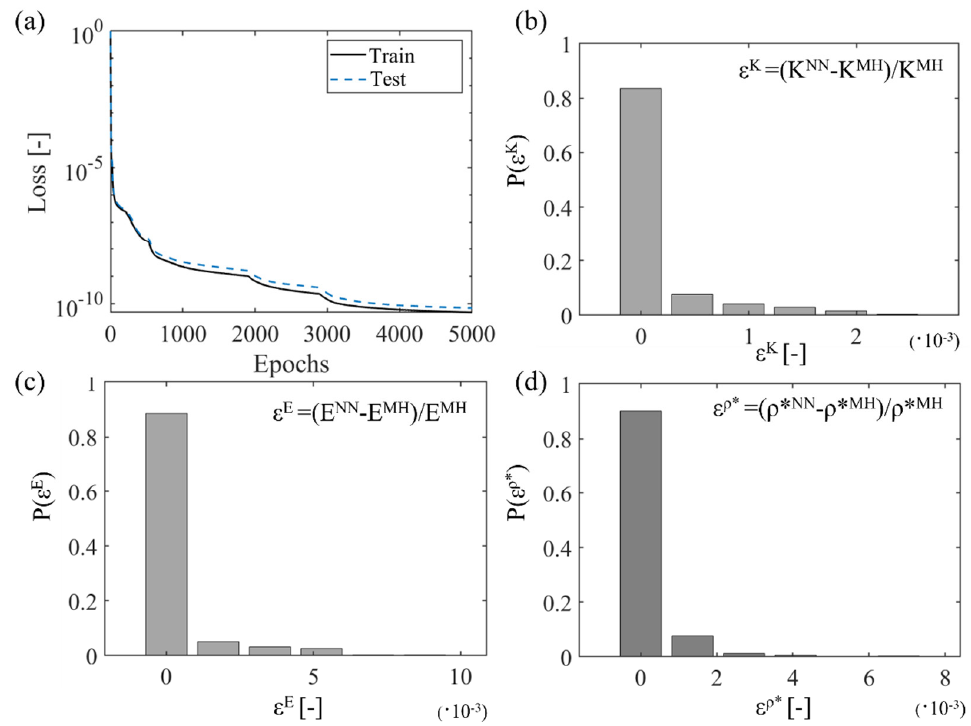
Figure 8. Training and test loss curves for the neural-network (NN)-based modeling of the mechanical response of multiscale honeycomb metamaterial designs ( a ). Error probability distribution of bulk ( b ) and normal ( c ) modulus and relative density value ( d ) for the validation dataset of 1000 random-input-feature generation. Relative error values below 0.05% are considered, for all practical purposes, as